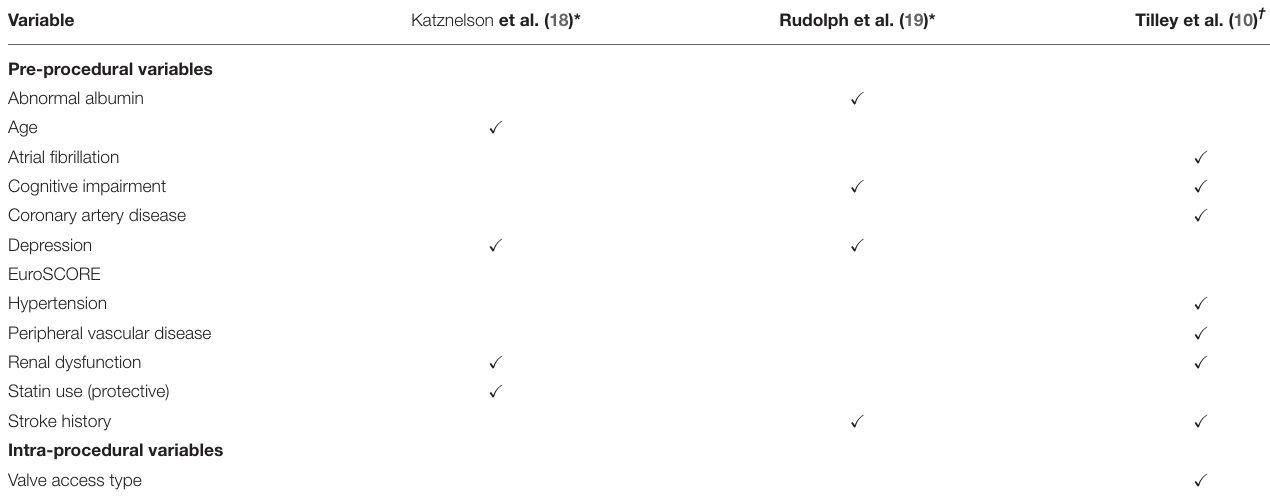
TABLE 1 | Risk factors from existing prediction models for post-cardiac procedure delirium and from meta-analysis of post-TAVI delirium predictors.